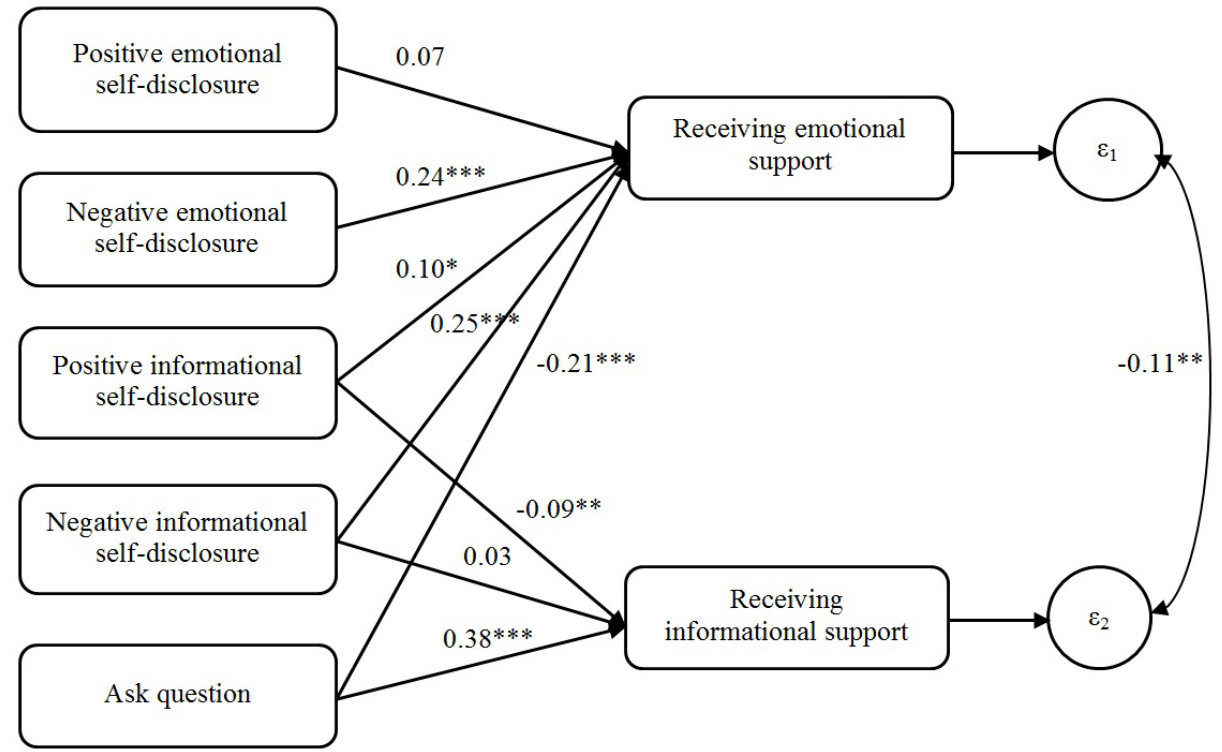
Figure 2. Path model showing the analysis of the social support communication process based on Turker-coded data. Values represent